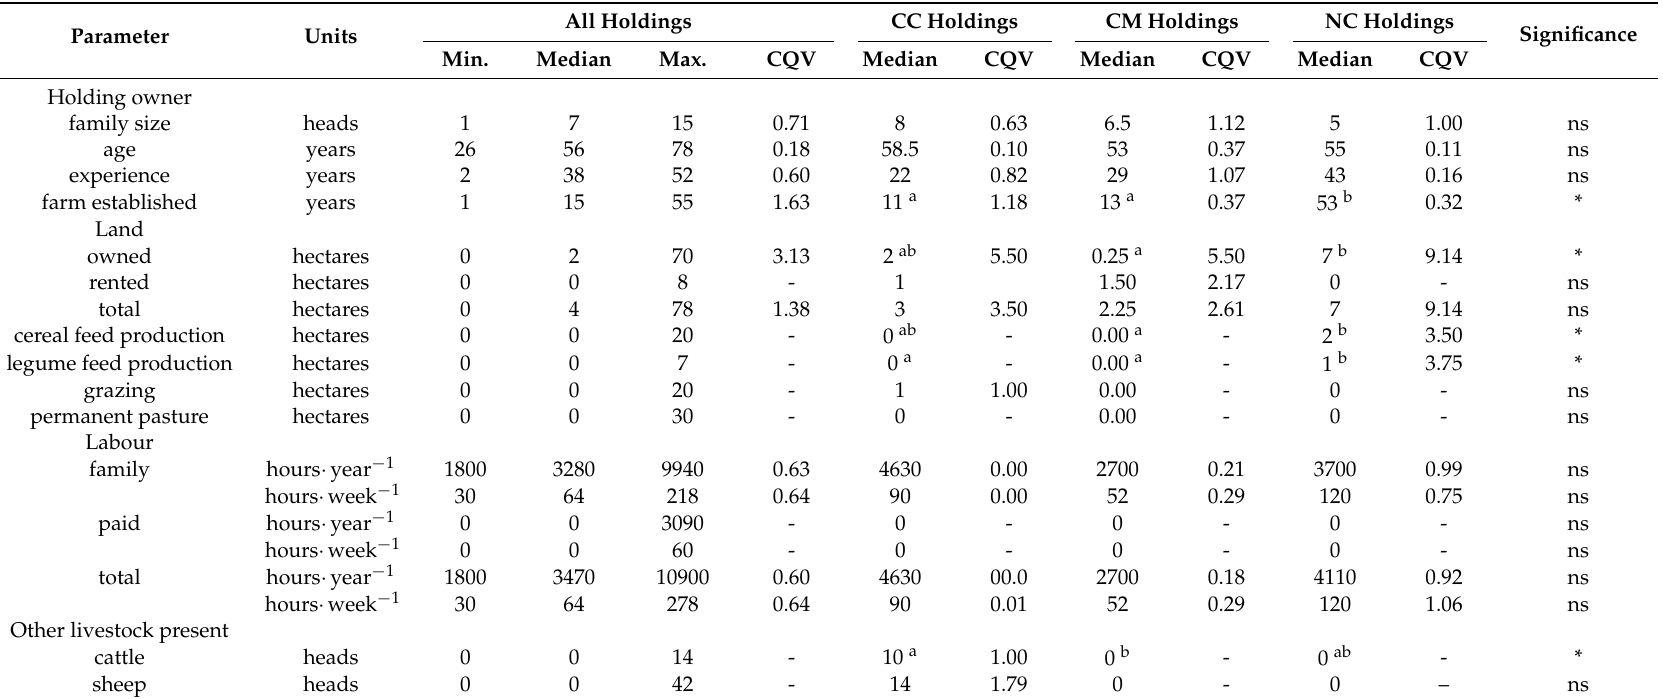
Table 3. Descriptive statistics for parameters relating to the holding owner, land and labour utilisation and the presence of other livestock on ten goat holdings in the northern region of Morocco based on monthly data collections between September 2009 and August 2012. Holdings are classified by their dairy production status: commercial cheese (CC, n = 3), commercial milk (CM, n = 4) and non-commercial dairy (NC, n =